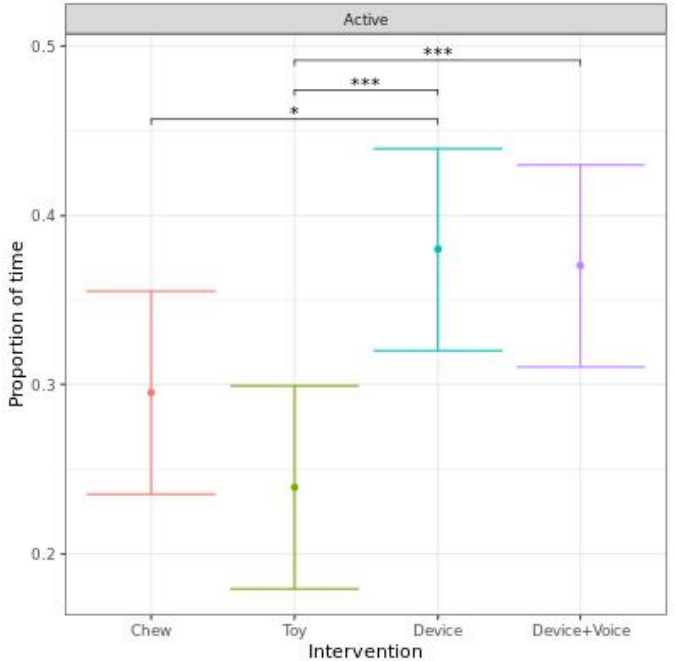
Figure 5. Predicted proportion (95% CI) of time spent active when “not engaged” when dogs were left alone with one of four enrichments for 20 min. Asterisks indicate significant differences between treatments groups. Three asterisks indicate significance at p < 0.001, and one asterisk indicates significance at p < 0.05.